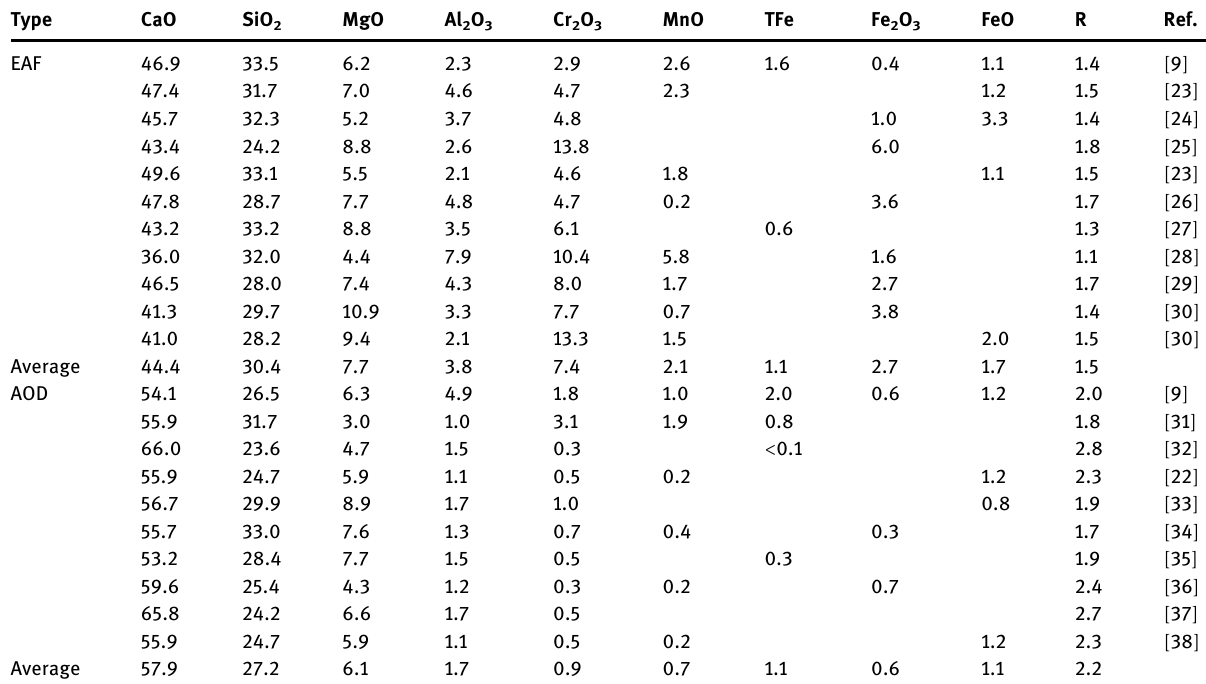
Table 2: Chemical composition of EAF and AOD slags in wt% Type